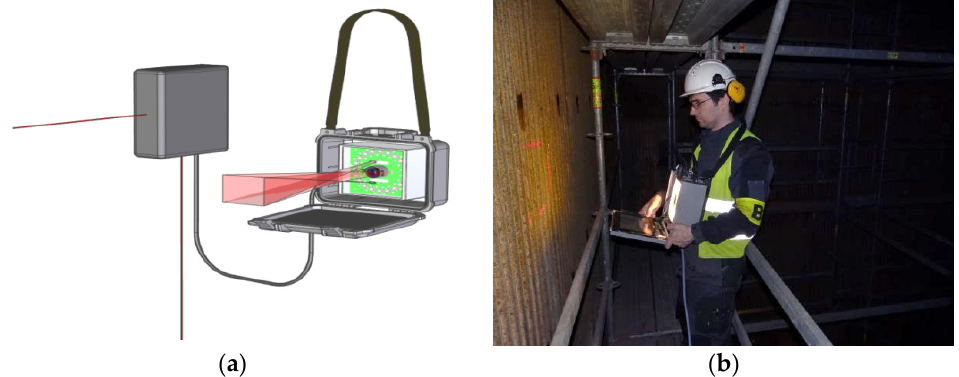
Figure 5. Schematic construction of the device intended for taking photographs of the boiler walls and illustration demonstrating the OP-230 boiler firebox during a test: ( a ) a sketch of the device; ( b ) the measurement